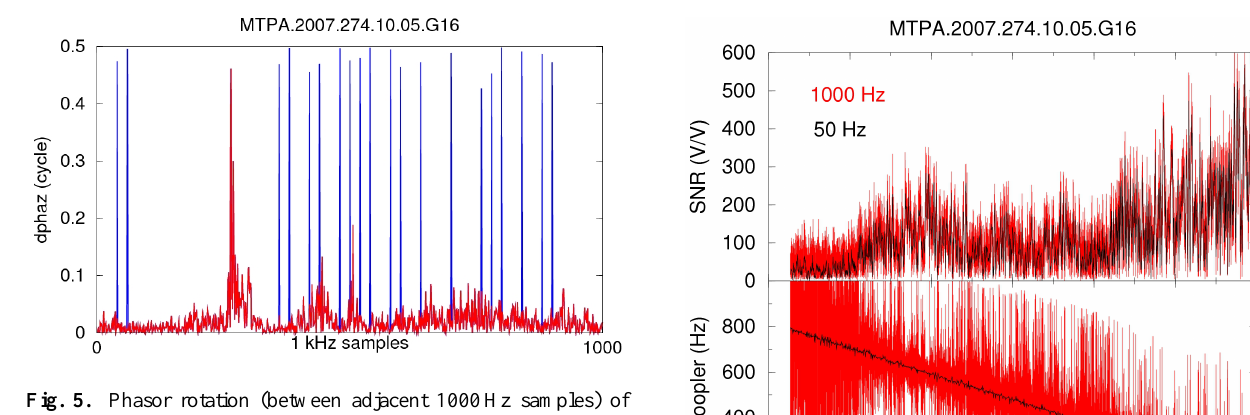
Fig. 5. Phasor rotation (between adjacent 1000Hz samples) of Gras/METOP raw sampled RO signal down-converted with the fre- quency model based on refractivity climatology. Blue line corre- sponds to original signal (50Hz navigation data modulation phase jumps are well seen); red line corresponds to the signal after re- moval of the 50Hz modulation.